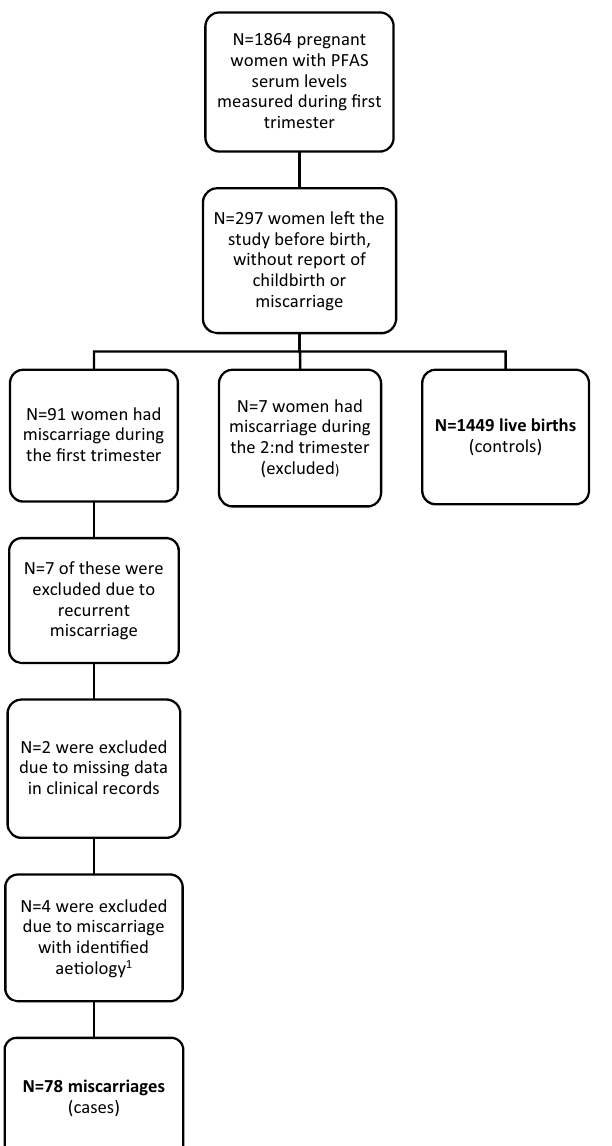
Figure 1. Description of inclusion and exclusion